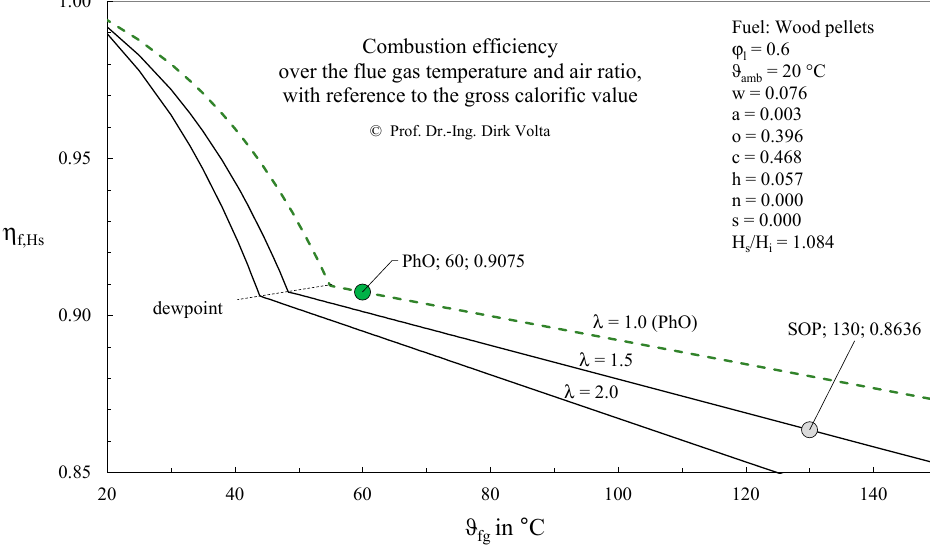
Figure 4. Combustion efficiency for wood pellets, with reference to the gross calorific value. In the PhO , the combustion efficiency amounts to 90.75%. This corresponds to an exhaust loss which cannot fall below q a,Hs,PhO = 9.25% for this case. Thus, in the PhO , if 100 units of fuel are fed to the system, Q N,PhO = 90.75 units of useful heat can be provided. For the real case, the standard operating point ( SOP ) is shown in Figure 4. The exhaust loss sums up to q a,Hs = 13.64%, which means that it is q a,Hs, ∆ Ω = 4.39% higher than the ideal case. This equals the potential for optimization. Figures 5 and 6 illustrate the losses. If the input is assumed to be constant, a higher amount of useful heat can be gained for the PhO . Furthermore, the distinction between unavoidable and avoidable losses is shown.